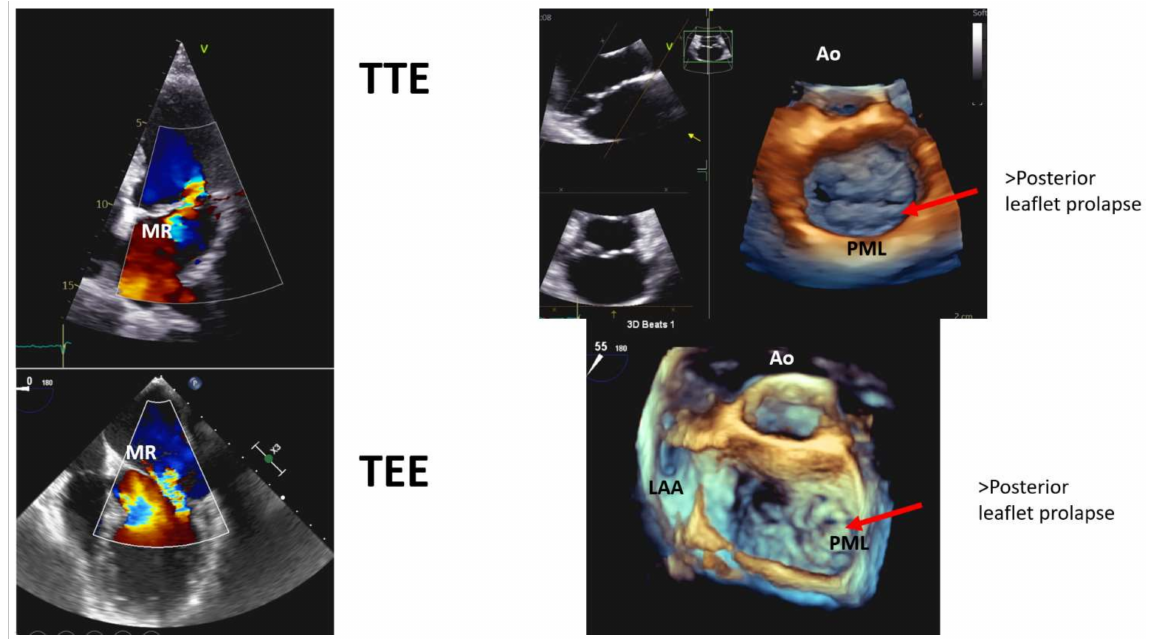
Figure 6. Comparison between transthoracic (TTE) and transesophageal echocardiography (TEE) in the assessment of mitral valve structure and mitral regurgitation (MR). Ao, aorta; LAA, left atrial appendage; PML, posterior mitral